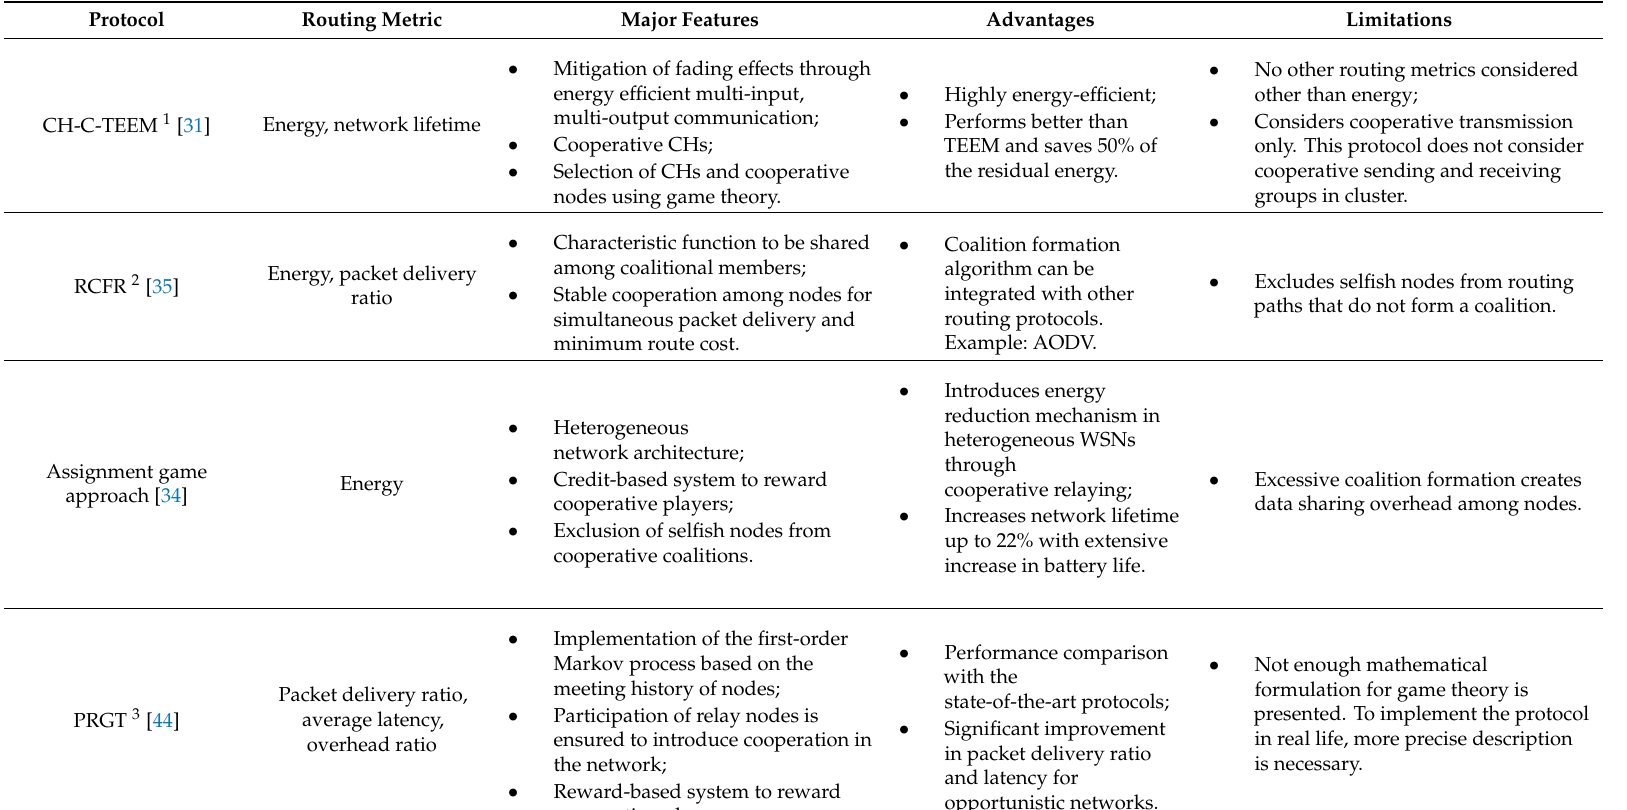
Table 7. Comparison of routing protocols based on cooperative